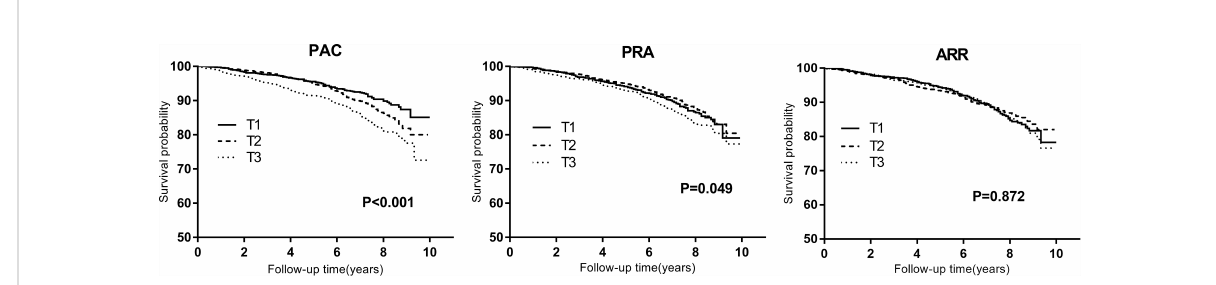
FIGURE 2 Kaplan-Meier curves for composite outcomes across tertiles of plasma aldosterone concentration (PAC), plasma renin activity (PRA), and aldosterone-to-renin ratio (ARR). T1 to T3 indicate ascending tertiles; T1 below 10.35(n=1058), T2 10.35 – 16.69 (n=1057), T3 above 16.69 (ng/dl) (n=1058) for PAC; T1 below 0.80(n=1055), T2 0.80 – 2.16 (n=1064), T3 above2.16 (ng/ml per h) (n=1054) for PRA; T1 below 6.05(n=1057), T2 6.05 – 16.33 (n=1060), T3 above 16.33(ng/dl)/(ng/ml per h) (n=1056) for